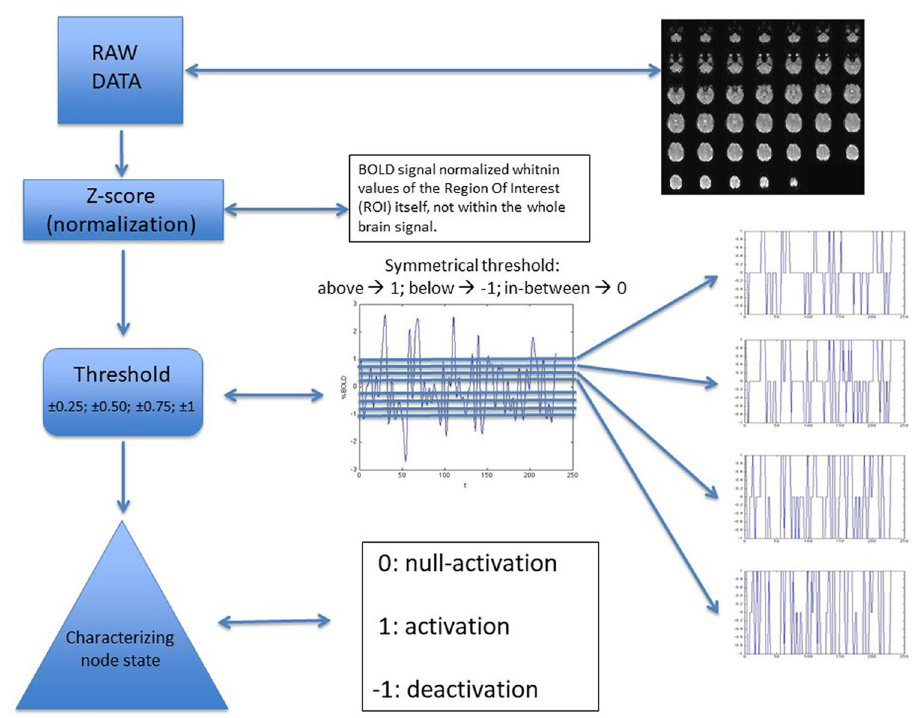
Figure 1. Flow chart of brain signal processing. Brain signals of each subject were submitted, after pre- processing, to the following procedure: Z-score normalization of time-series; thresholding by four symmetrical thresholds; discretization of signal values in: 1, − 1 and 0. Thus, each signal is redefined as a dynamic process involving: activation (1), de-activation (− 1) and null-activation